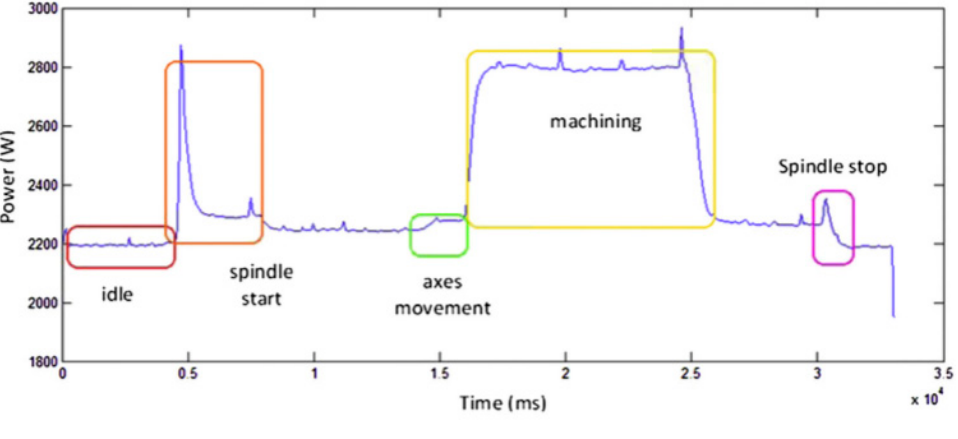
Figure 1. Power curve during an actual machining process [25].